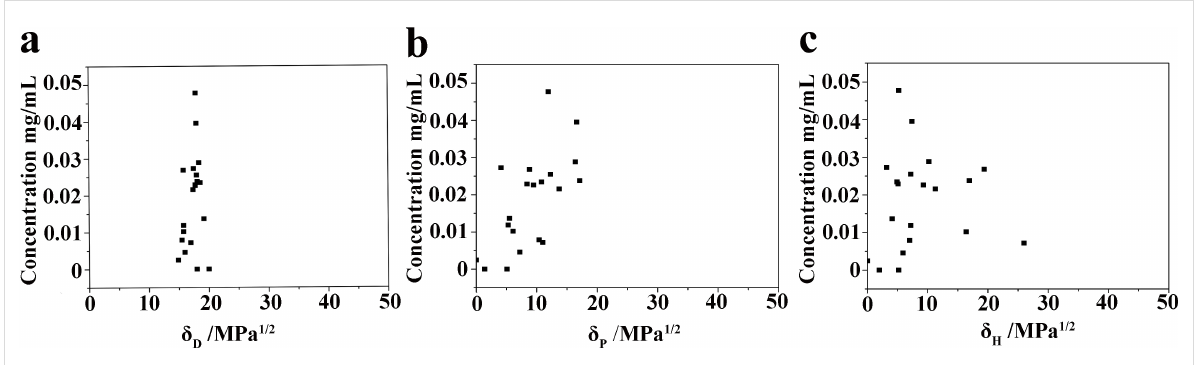
Figure 4: Concentration of KP 15 dispersions as a function of the Hansen parameters. (a) Concentration of KP 15 dispersions as a function of δ D . (b) Concentration of KP 15 dispersions as a function of δ P . (c) Concentration of KP 15 dispersions as a function of δ H .